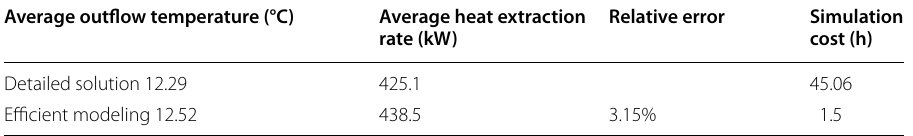
Table 7 Comparison between the simulation results of detailed solution versus efficient modeling Average outflow temperature